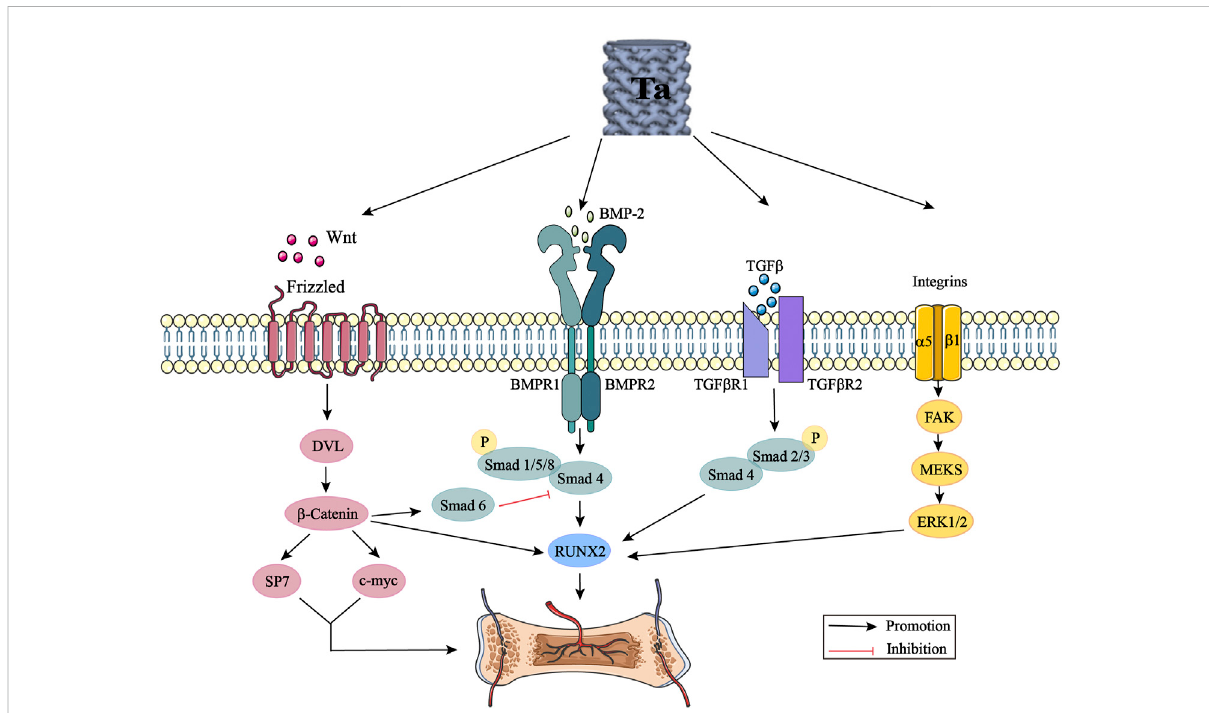
FIGURE 3 Tantalum activates the Wnt/ β -catenin signaling pathway, BMP signaling pathway, TGF- β signaling pathway and integrin signaling pathway by promoting the expression of Wnt, BMP-2, TGF- β and integrins. DVL: disheveled; BMP: bone morphogenic proteins; Smad: small mother against decapentaplegic; Runx2: runt-related transcription factor 2; TGF- β : transforming growth factor-beta; FAK: focal adhesion kinase; ERK: extracellular signal regulated